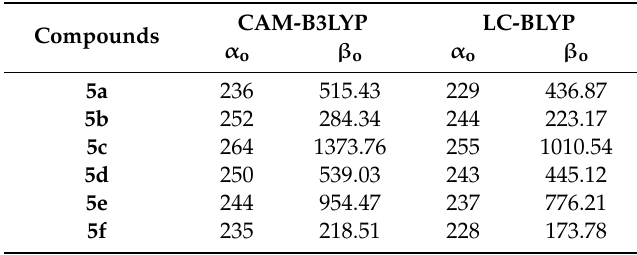
Table 5. Polarizability ( α o ) and hyperpolarizability ( β o ) of compounds 5a – f with CAM-B3LYP and LC-BLYP